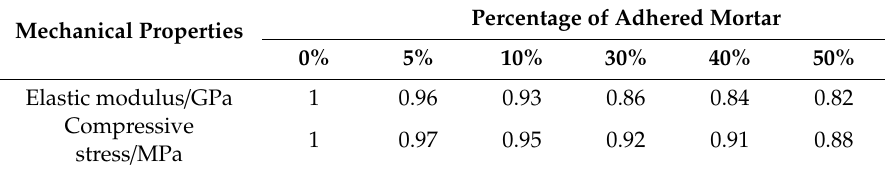
Table 4. E ff ect of the percent of adhering mortar on the mechanical properties of RAC. Mechanical Properties